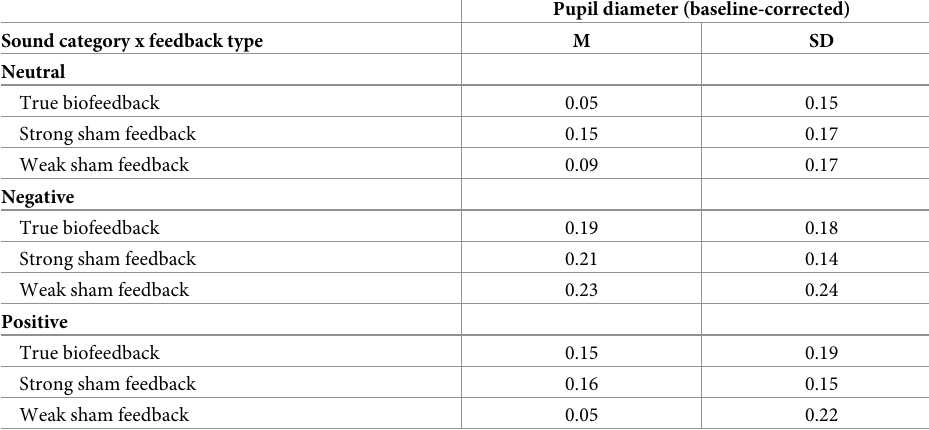
Table 3. Baseline-corrected pupil size data divided by category and feedback